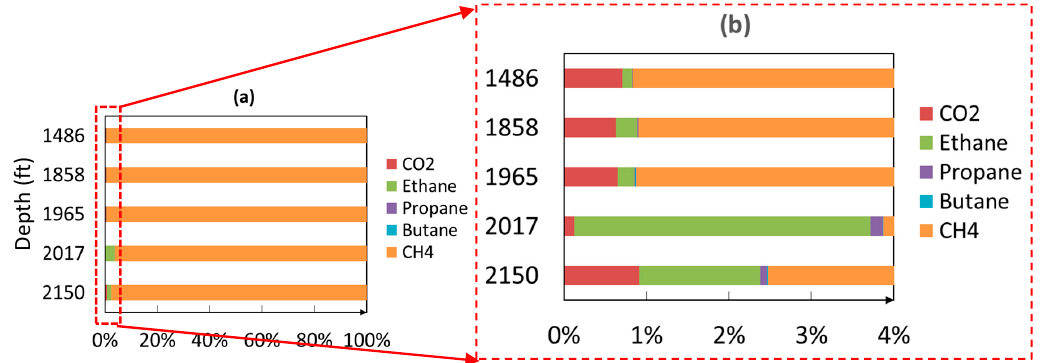
Figure 5. Gas composition of accumulated CBM sample: ( a ) represents gas composition of accumulated CBM sample from shallow seams to deep seams and ( b ) represents an enlarged section of Figure (5a).